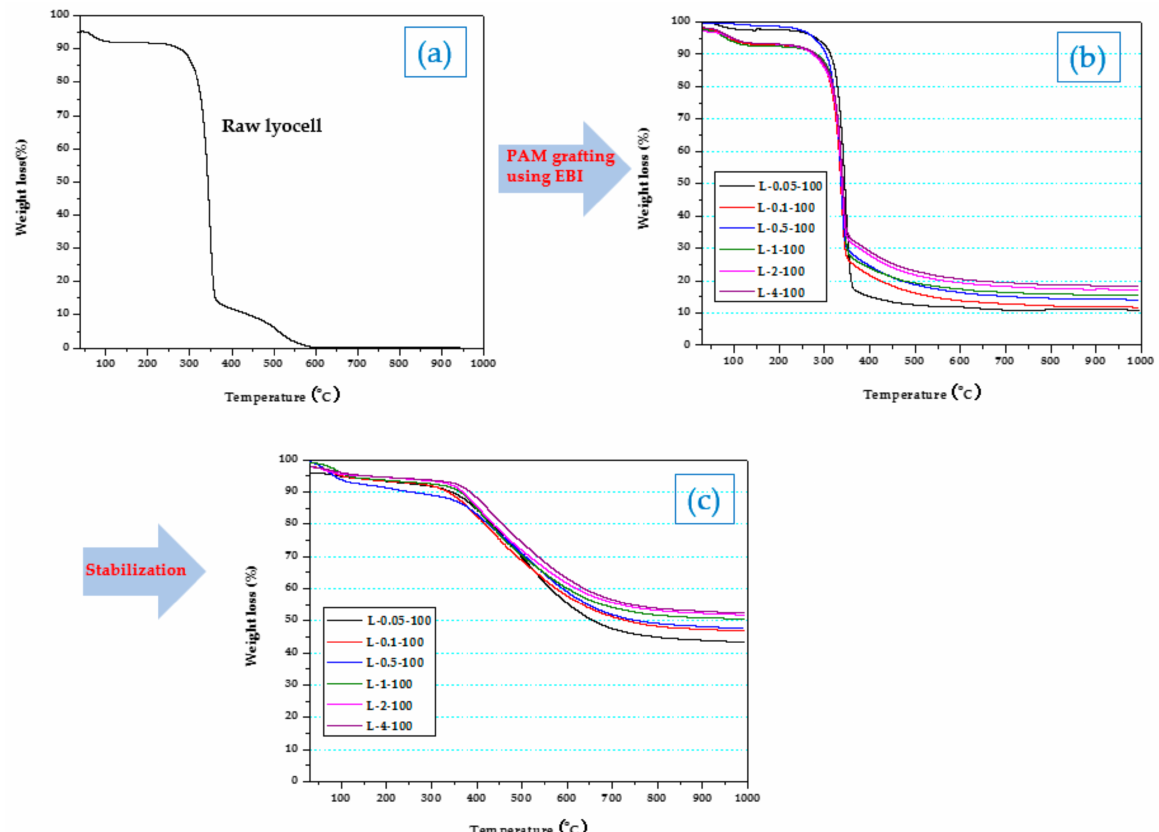
Figure 2. TGA analysis of ( a ) raw lyocell, ( b ) lyocell grafted with PAM via EBI before stabilization, and ( c ) lyocell grafted with PAM via EBI after thermal